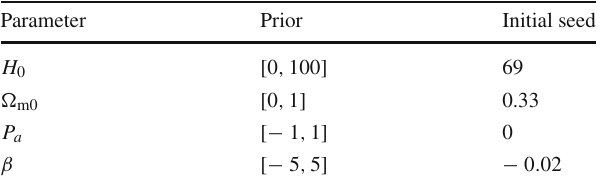
Table 2 The priors and initial seeds of parameters used in the posterior analysis Parameter Prior Initial